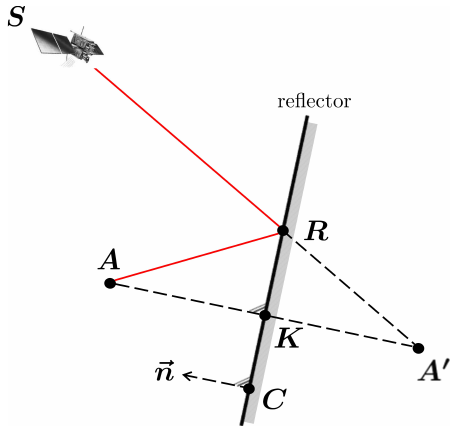
Figure 10. Ray-tracing for determination of reflection point R .